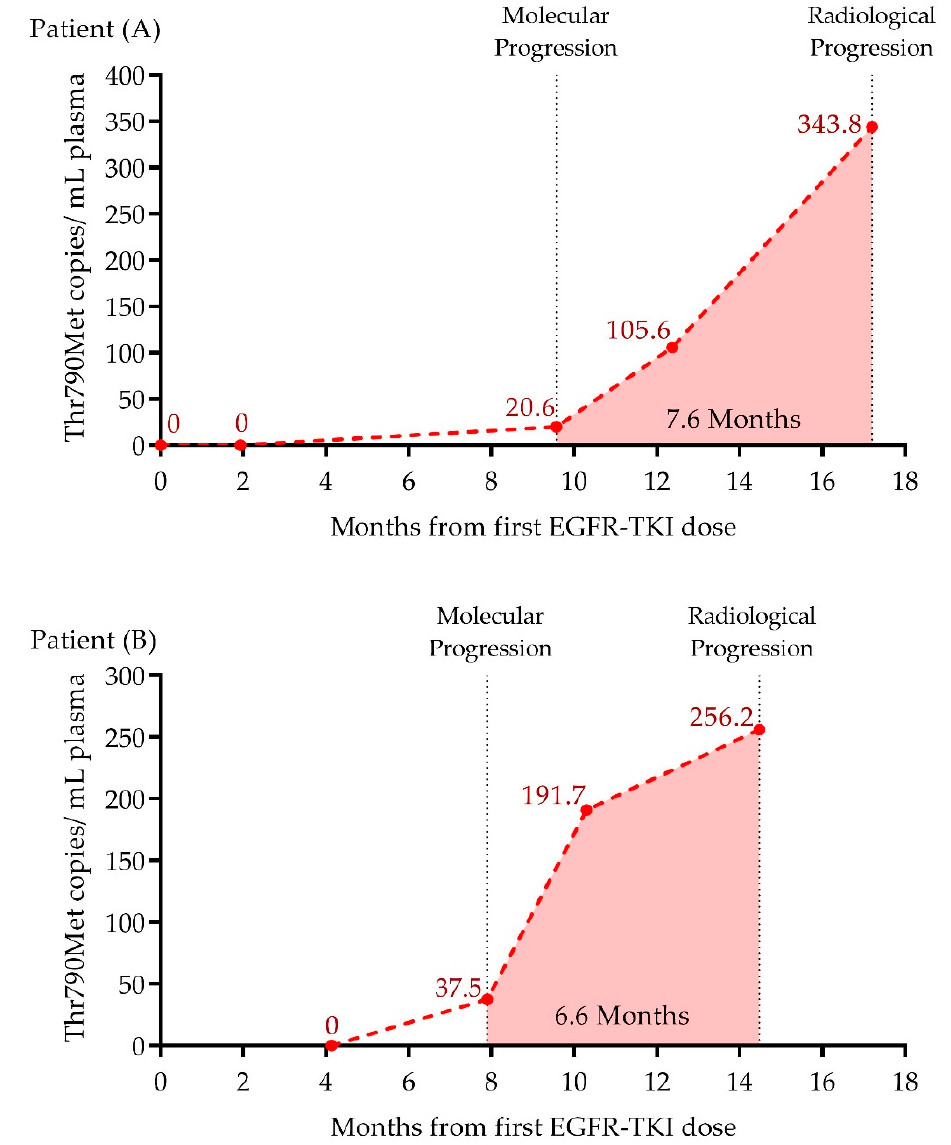
Figure 5. Dynamics of EGFR -Thr790Met mutation detected by ddPCR during follow-up in NSCLC patients treated with EGFR-TKI. Patients A and B ( A , B ). Red dots represent the EGFR -Thr790Met copies/mL of plasma detected in each sample. Molecular progression and radiological progression are depicted. Light red filled area comprises the months between these moments.